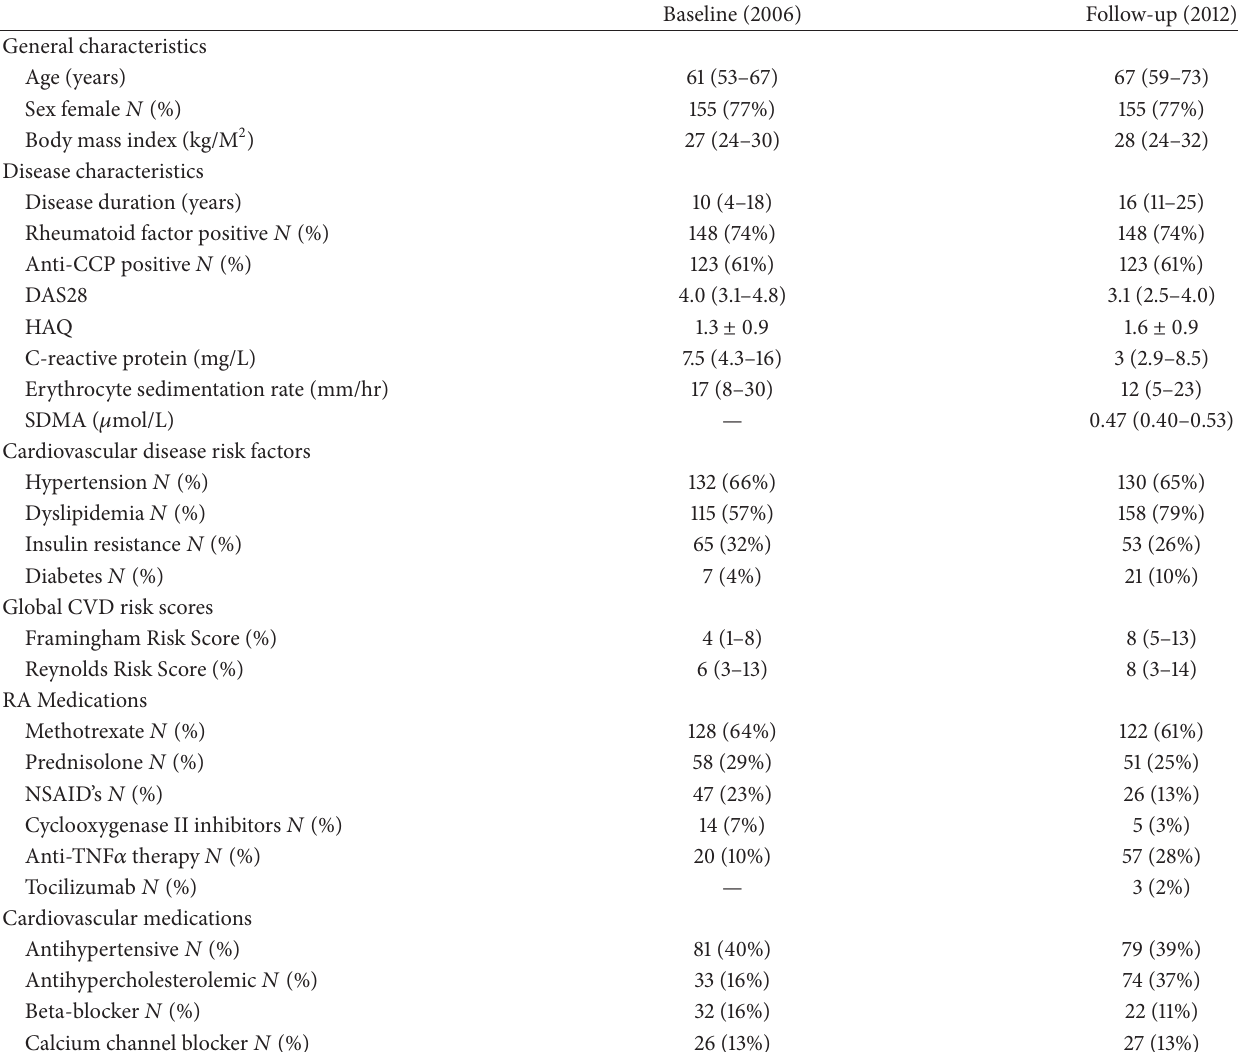
Table 1: Patient characteristics at baselineand at follow-up (Sandoo A, Dimitroulas T, Hodson J,Smith JP,Douglas KM, Kitas GD. Cumulative inflammation associates with asymmetric dimethylarginine in rheumatoid arthritis: a 6 year follow-up study. Rheumatology. 2014 Sep 3. [Ahead of print]. Reproduced with permission from Oxford University